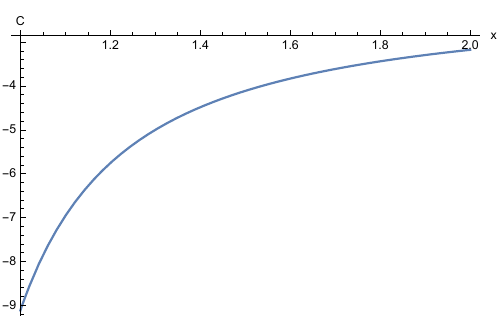
Figure 2. m = M = G = k B = 1, and x = 1/ T . Plot of < U ( x ) > . At large temperatures (near the origin), the binding and kinetic energies, as well as the temperature are large, as prescribed by item (1) of the introduction. As T decreases, so does the binding and kinetic energies, as indicated by item (2) of the Introduction.